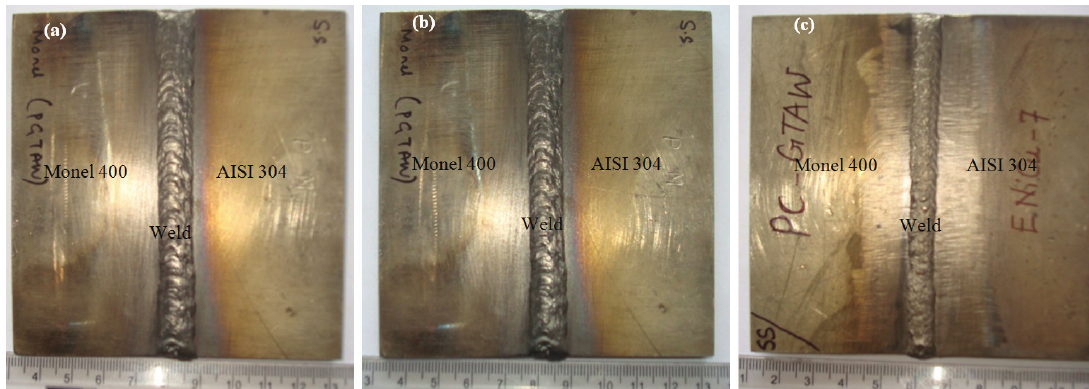
Figure 1. Dissimilar welds of Monel 400 and AOSO 304using (a) ER309L (b) ERNiCu-7 (c) ERNiCrFe-3 by PCGTAW